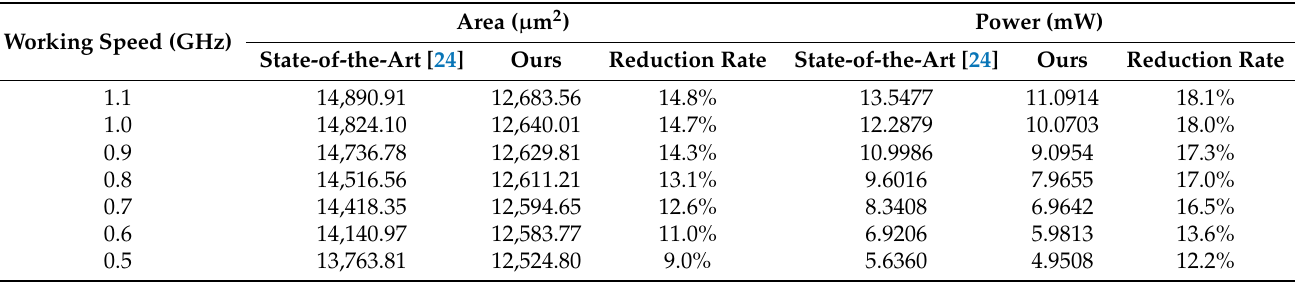
Table 2. Comparisons on different 3 × 3 convolver designs.